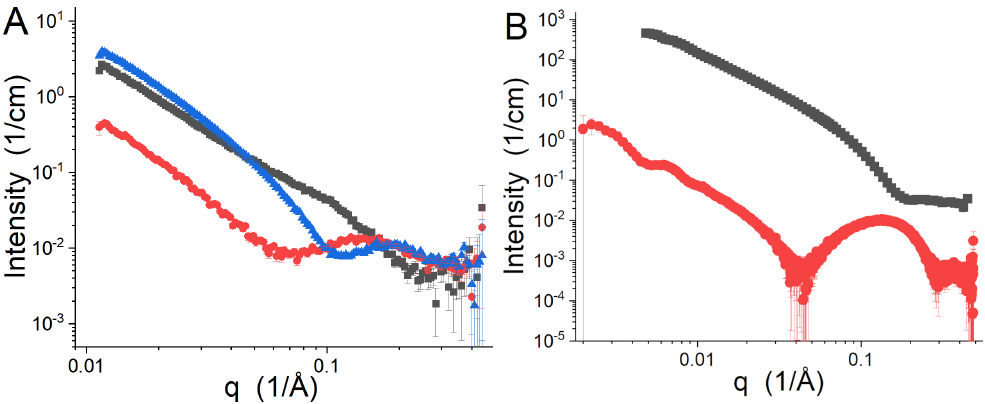
Figure 3. ( A ) SANS data from 7:3 2 H 54 -DMPC:DMPE at 55 ◦ C in 50% 2 H 2 O (black squares), 70% 2 H 2 H 2 O (red circles), and 90% 2 O (blue triangles). The data were collected using the EQ-SANS instrument [88] and have not been previously published. ( B ) SANS (black squares) and SAXS data (red circles) of 7:3 DMPC:DMPG vesicles in 2 H 2 O. The SANS data were taken from a previously published study [89], while the SAXS data were collected from Sector 12-ID-B of the Advanced Photon Source of Argonne National Laboratory and have not been previously